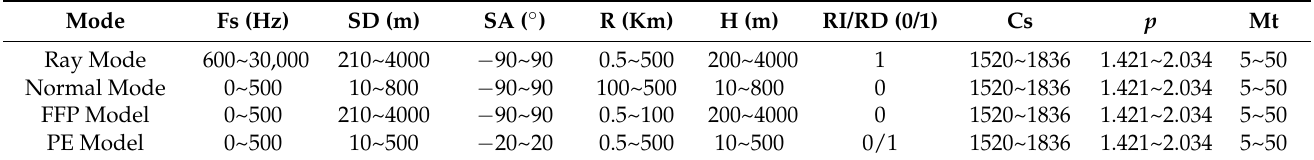
Table 2. Underwater acoustic transmission loss mode characteristic parameter